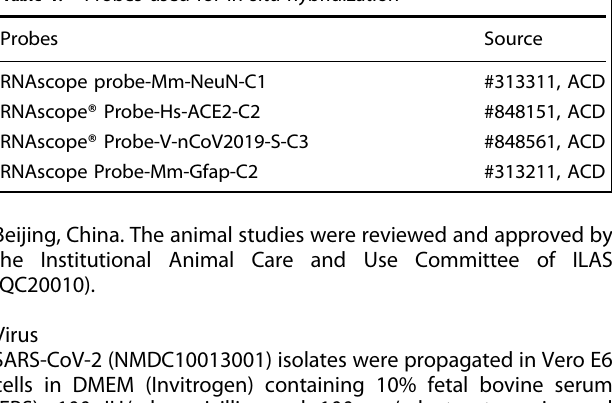
Table 1. Probes used for in situ hybridization Table 2. The antibodies used in the present